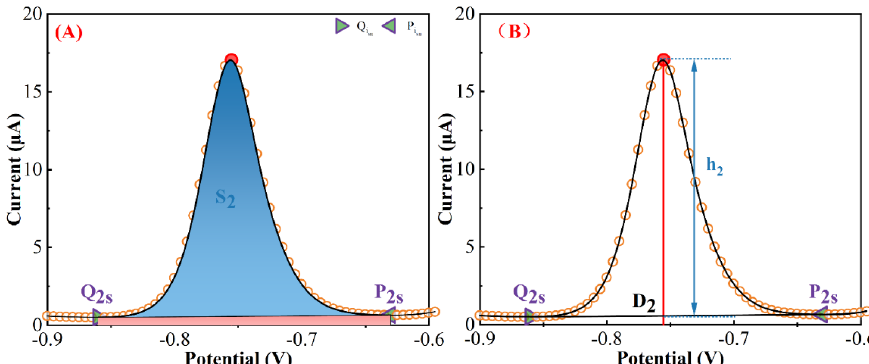
Figure 3. Schematic representation of peak area ( A ) and peak height ( B ) calculation. (The i -th segment of the SWASV response curve for 150 µ g/L Zn 2+ , 35 µ g/L Cd 2+ , 175 µ g/L Pb 2+ , 300 µ g/L Bi 3+ , and 100 μg/L Cu 2+ ).